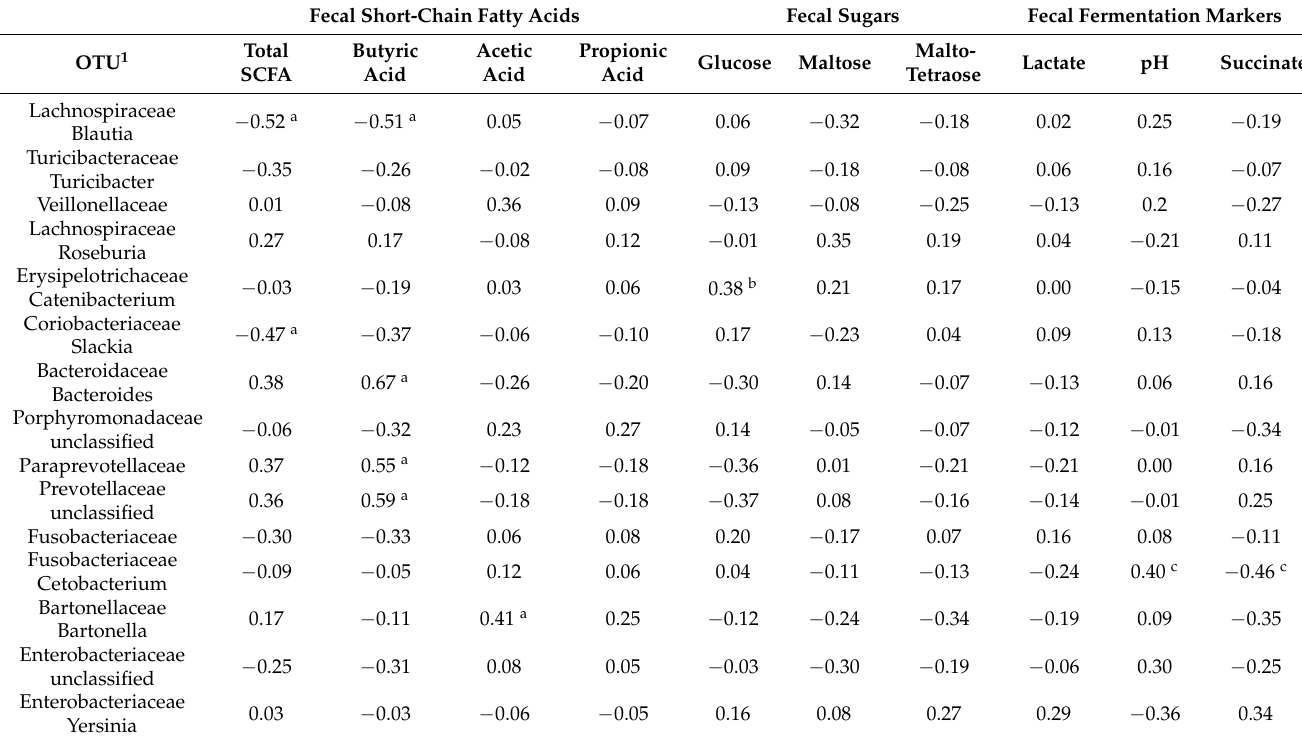
Table 7. Estimated Spearman rho’s correlations between selected operational taxonomic units (OTUs; expressed in centered log-ratio transformation) and concentration of fecal SCFA, lactate, pH, oligosaccharides and succinate (expressed as log 2